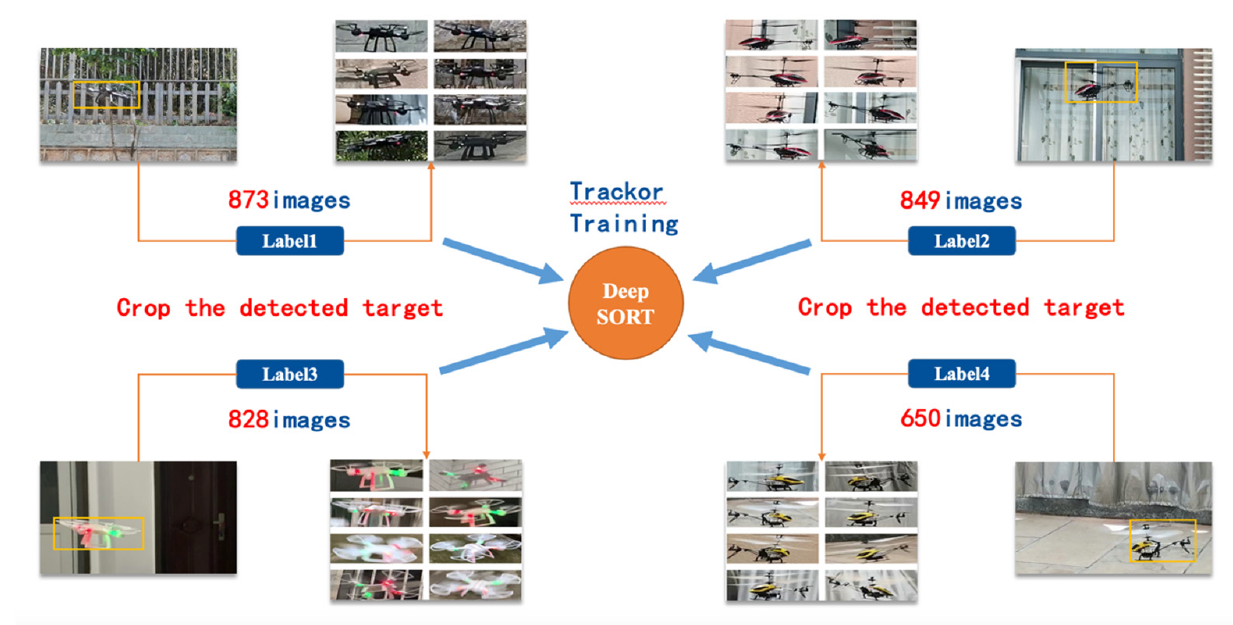
Figure 8. Construction method of UAV tracking dataset.